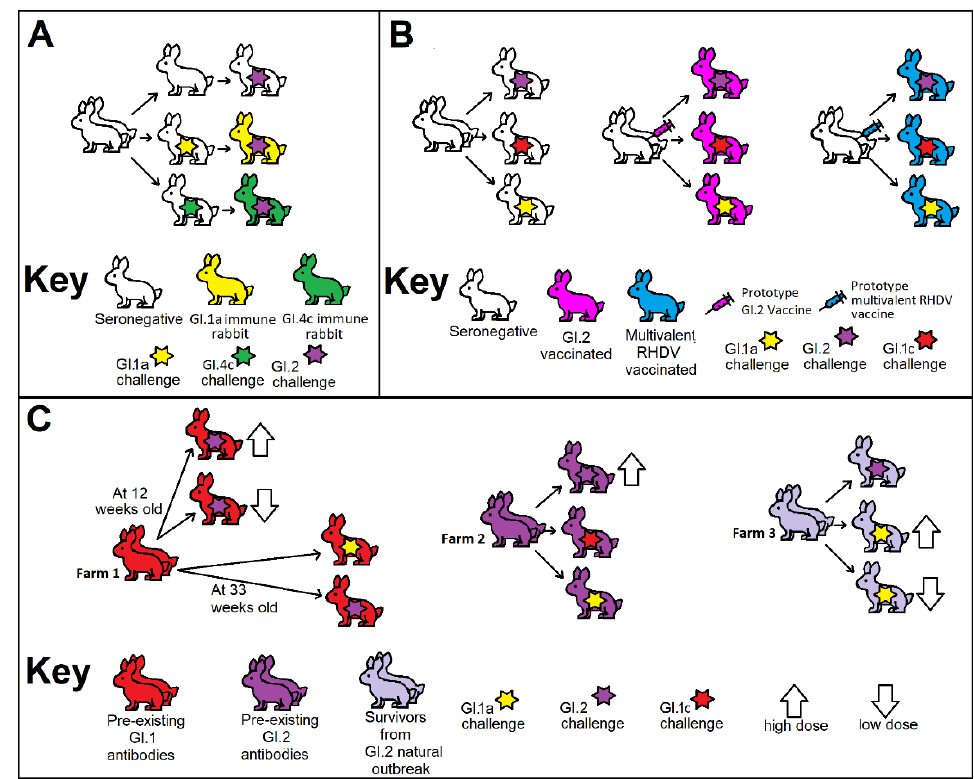
Figure 1. ( A ) Schematic diagram for the production and challenge of rabbits immune to GI.1a or GI.4c . Rabbits with antibodies against GI.1a or GI.4c were produced by initially infecting by the oral route of infection at five weeks of age. Rabbits were subsequently challenged orally with GI.1bP-GI.2 at 12 weeks of age. ( B ). Schematic diagram for the production and challenge of rabbits vaccinated with a prototype GI.2-specific vaccine or a multivalent RHDV vaccine. Rabbits were vaccinated via subcutaneous injection at 10–12 weeks of age, and subsequently challenged per os with heterologous RHDV variants 28 days after vaccination. ( C ) Schematic diagram for the challenge of rabbits with naturally acquired immunity from three commercial farms. Rabbits were challenged with various heterologous RHDV variants (at various ages and with various infectious doses).